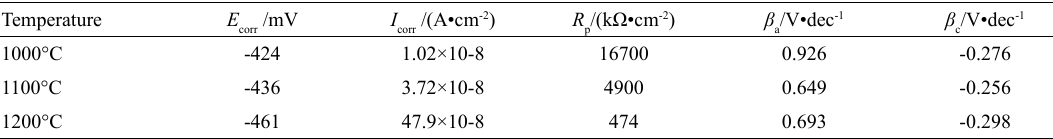
Table 2. Corrosion resistance parameters of CoNiCrMo